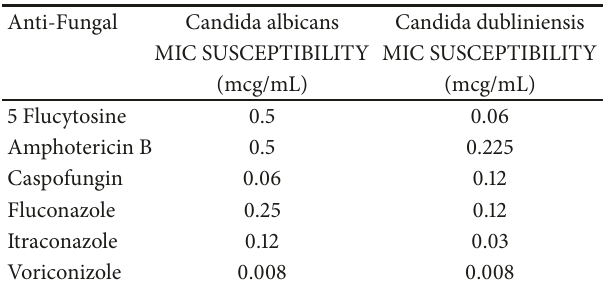
Figure1:Centralcornealepithelialdefectwithstromalinfiltrateand hypopyon. Table 1: Anti-Fungal Susceptibilities.